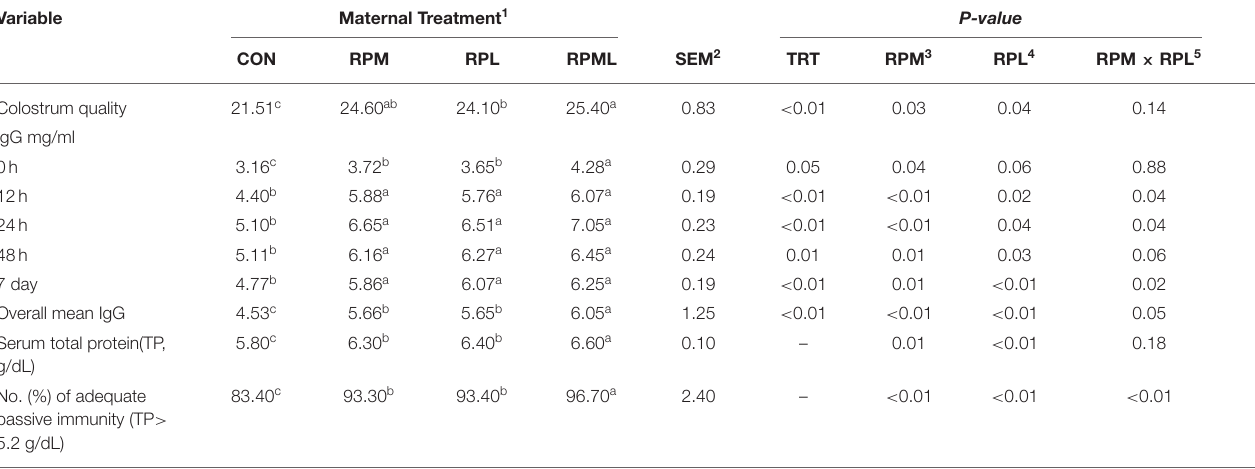
TABLE 4 | Effect of maternal supply of ruminally protected lysine or methionine and combination to pre-calving Holstein dairy cows on the immunity efficiency of their heifer calves 1 . Variable